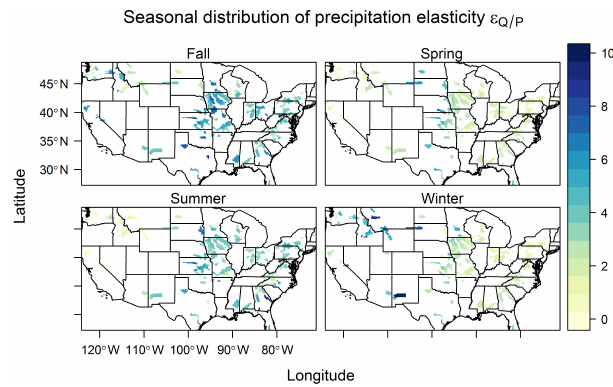
Figure 7. Seasonal distribution of streamflow elasticity due to pre- cipitation